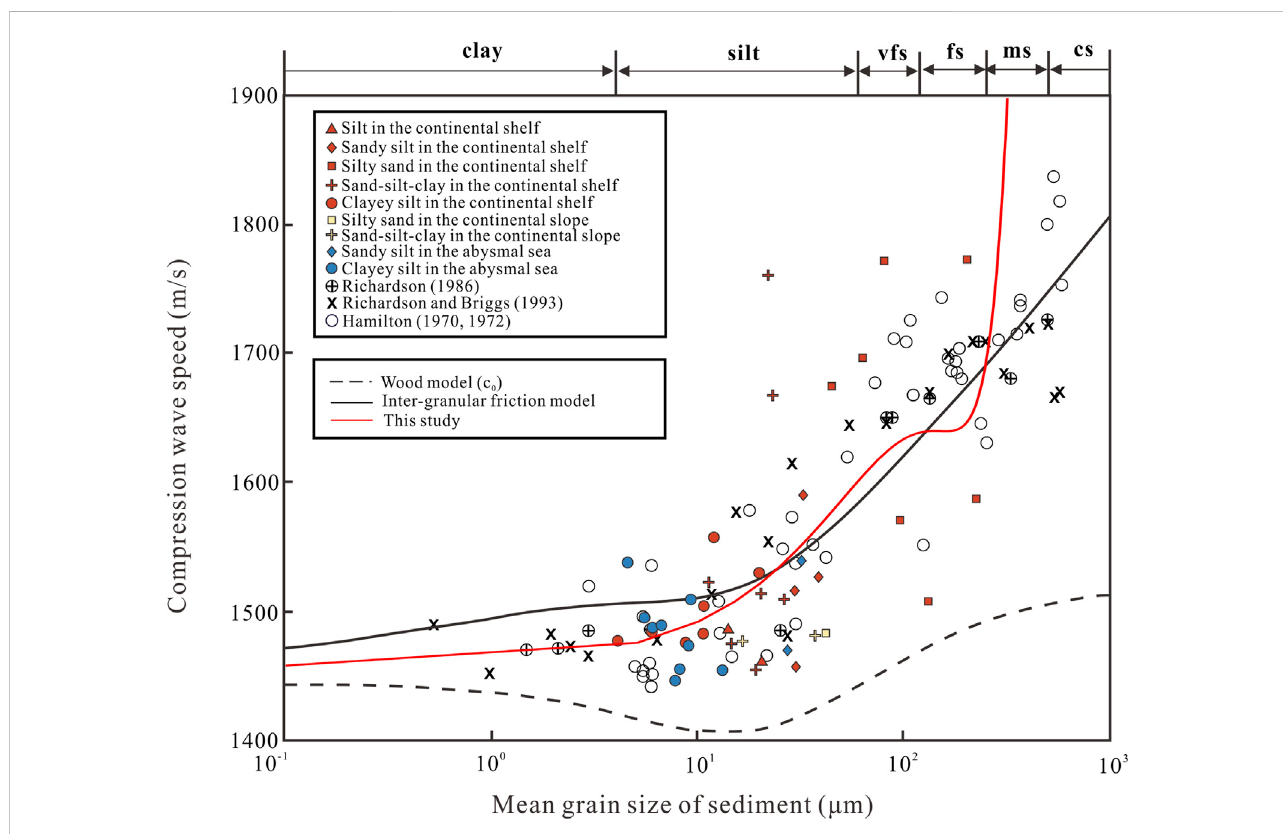
Relationship between the mean grain size and compression wave speed of sea fl oor